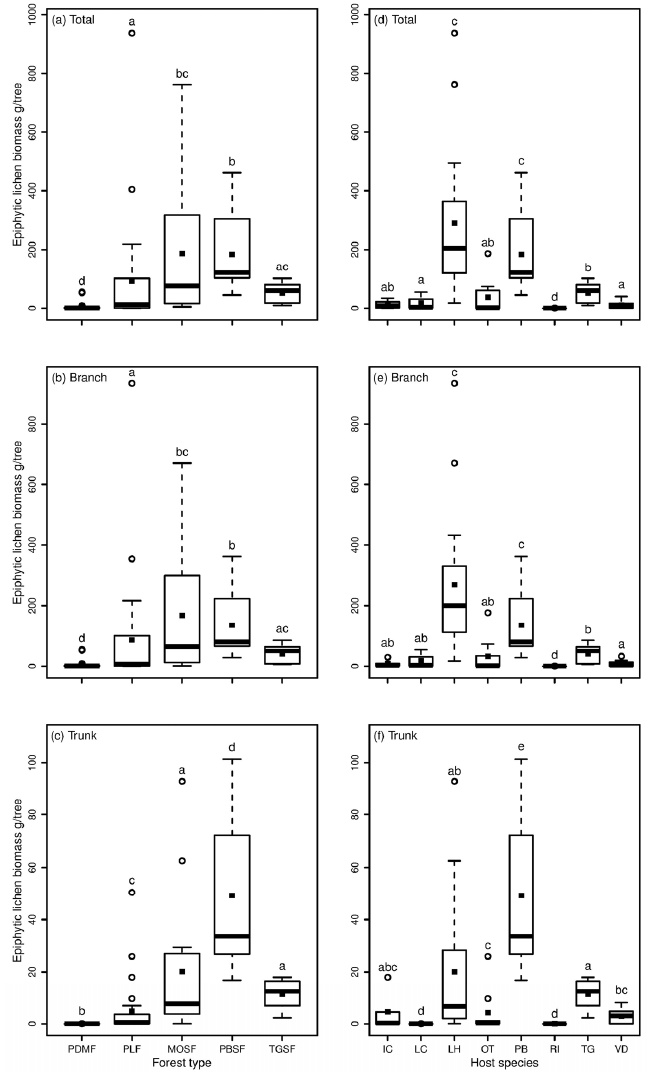
Figure 2. Epiphytic lichen biomass in five forest types ( a – c ) and on eight host species ( d – f ) in the Ailao Mountains, Southwest China. Different letters with bars represent significant differences. Solid squares symbolize the mean value. PDMF: primary dwarf mossy forest; PLF: primary Lithocarpus forest; MOSF: middle-aged oak secondary forest; PBSF: Populus bonatii secondary forest; TGSF: Ternstroemia gymnanthera secondary forest. IC: Ilex corallina ; LC: Lithocarpus crassifolius ; LH: Lithocarpus hancei ; OT: other mixed species; PB: Populus bonatii ; RI: Rhododendron irroratum ; TG: Ternstroemia gymnanthera ; VD: Vaccinium duclouxii .